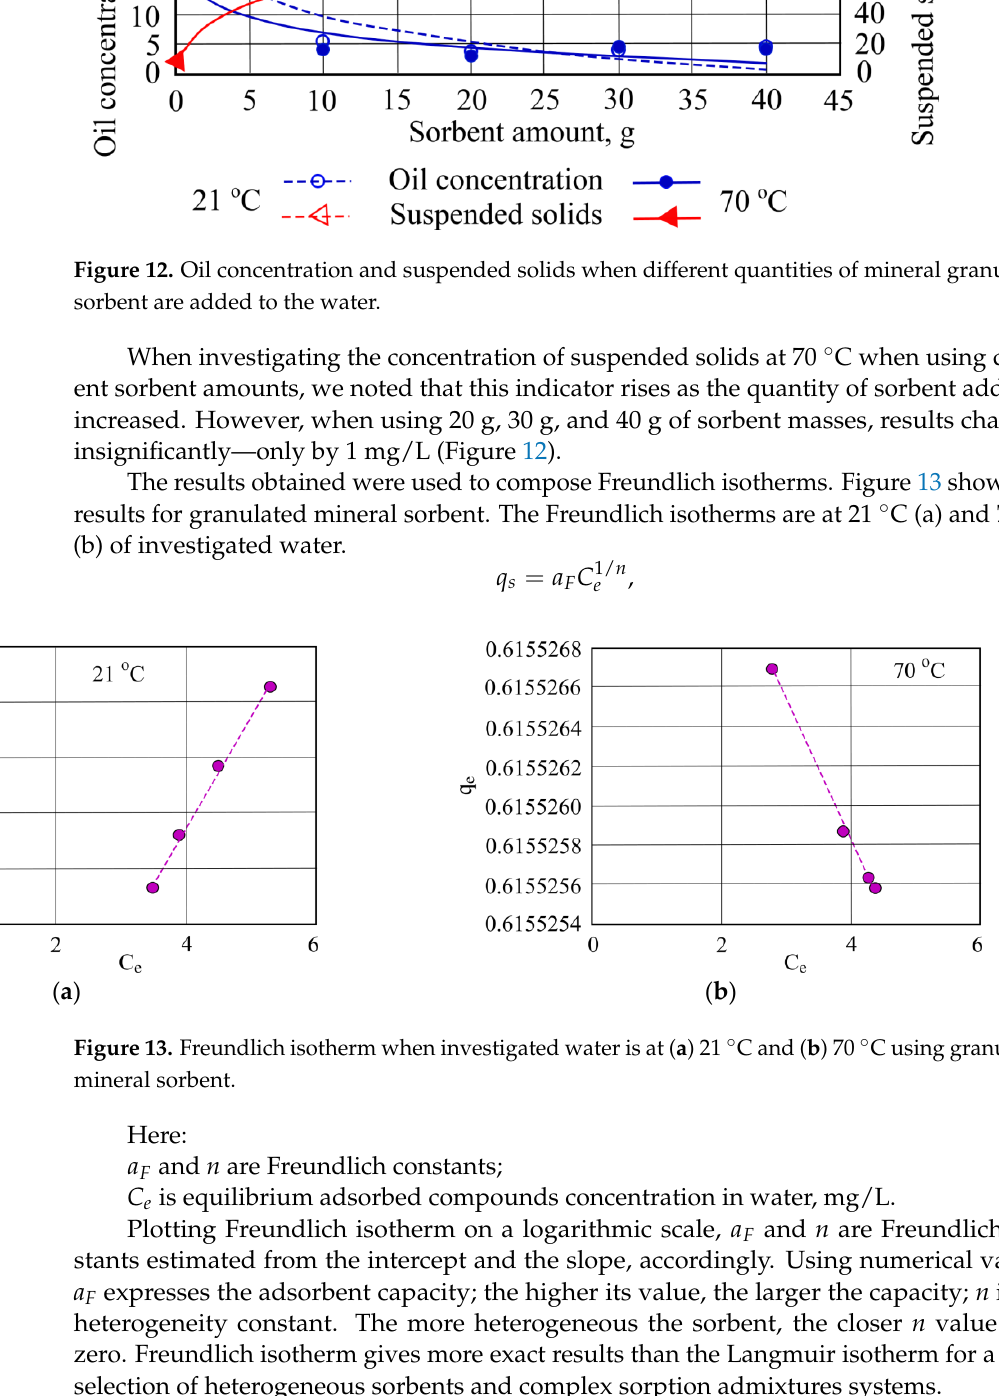
Figure 12. Oil concentration and suspended solids when different quantities of mineral granulated sorbent are added to the water.